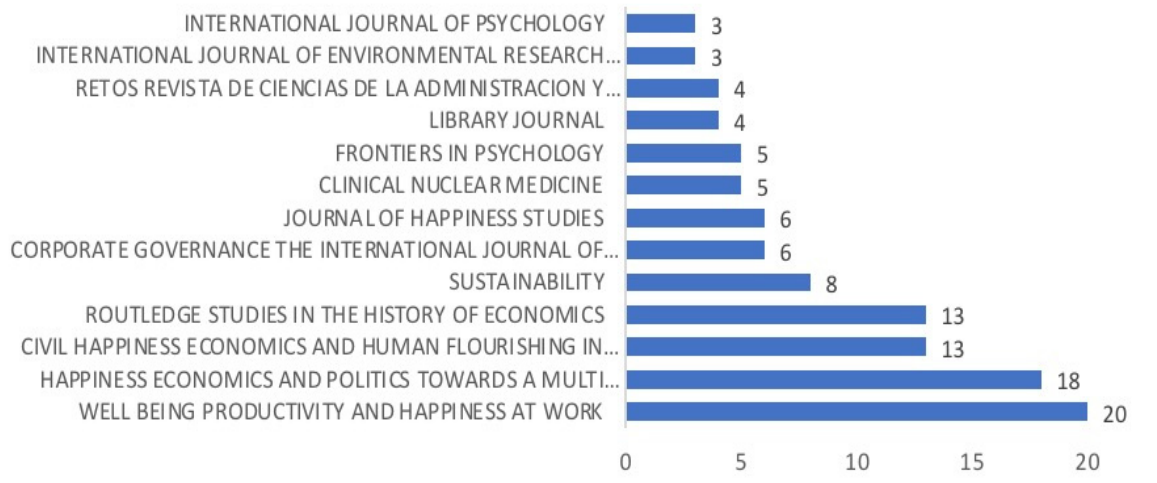
Figure 9. Journals with more than three published papers about the subject.